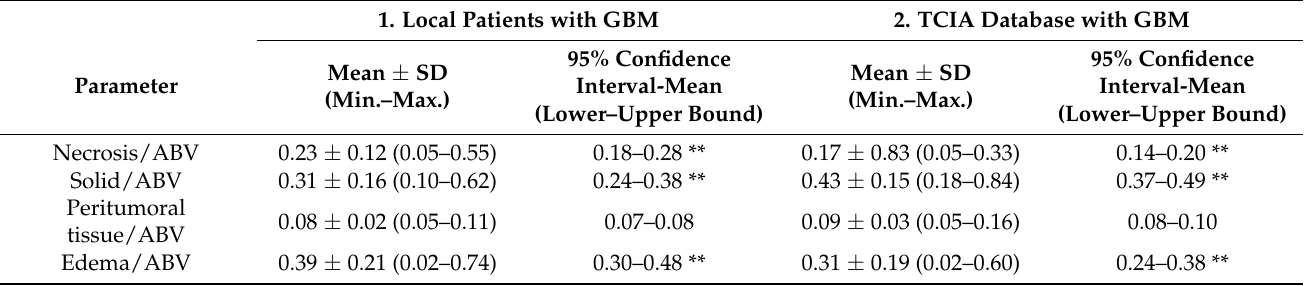
Table 1. Statistical abnormal bulk volume (ABV) comparisons between local patients with GBM and TCIA database as our validation cohort to carry out a pilot study. 1. Local Patients with GBM 2. TCIA Database with